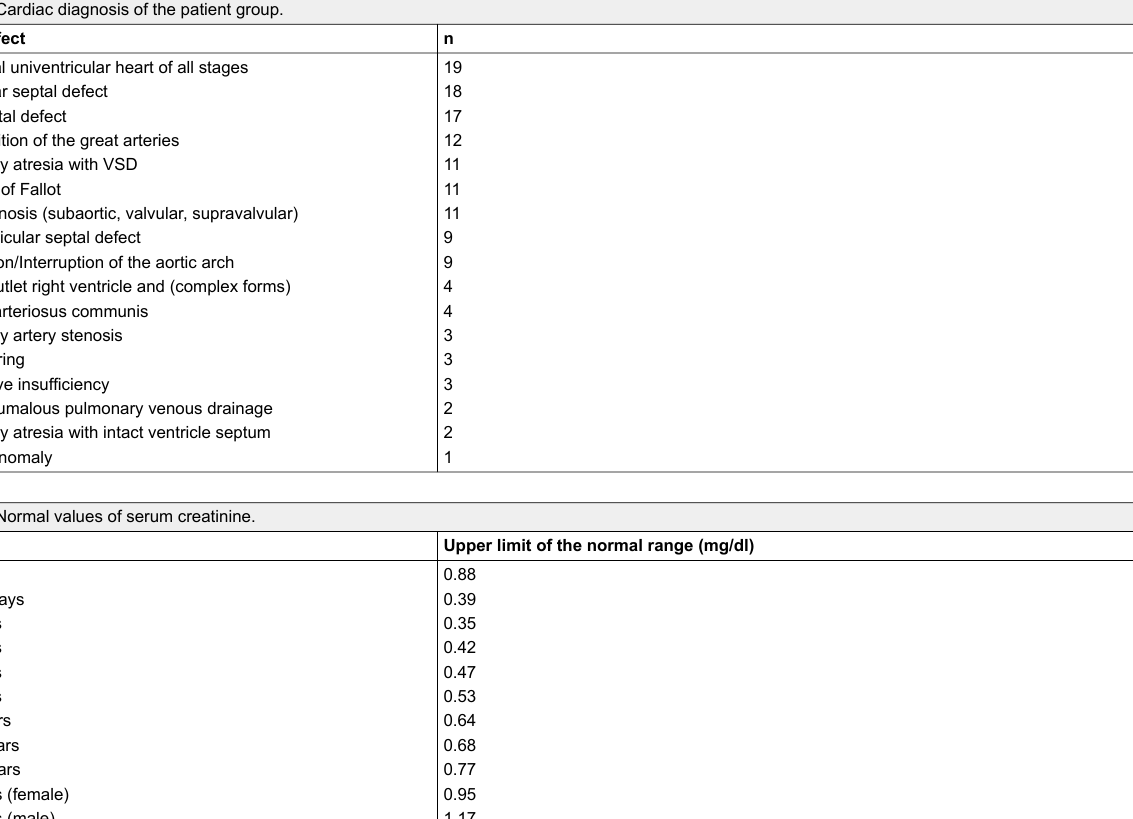
Table 1: Cardiac diagnosis of the patient group. Heart defect n Functional univentricular heart of all stages Ventricular septal defect Atrial septal defect Transposition of the great arteries Pulmonary atresia with VSD Tetralogy of Fallot Aortic stenosis (subaortic, valvular, supravalvular) Atrioventricular septal defect Truncus arteriosus communis Pulmonary artery stenosis